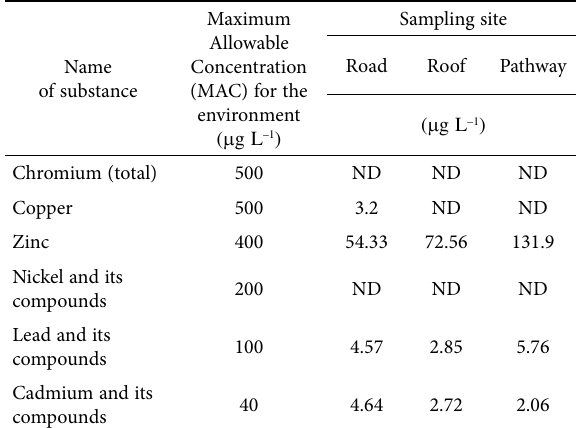
Table 3. The dissolved trace metal concentrations detected in the urban storm water runoff samples compared to the trace metal Maximum Allowable Concentration (MAC) limits for the environment according to the Order of the Minister of the Environment of Lithuania No. D1 – 236 of 17 May 2006 and its subsequent amendments based on Directive